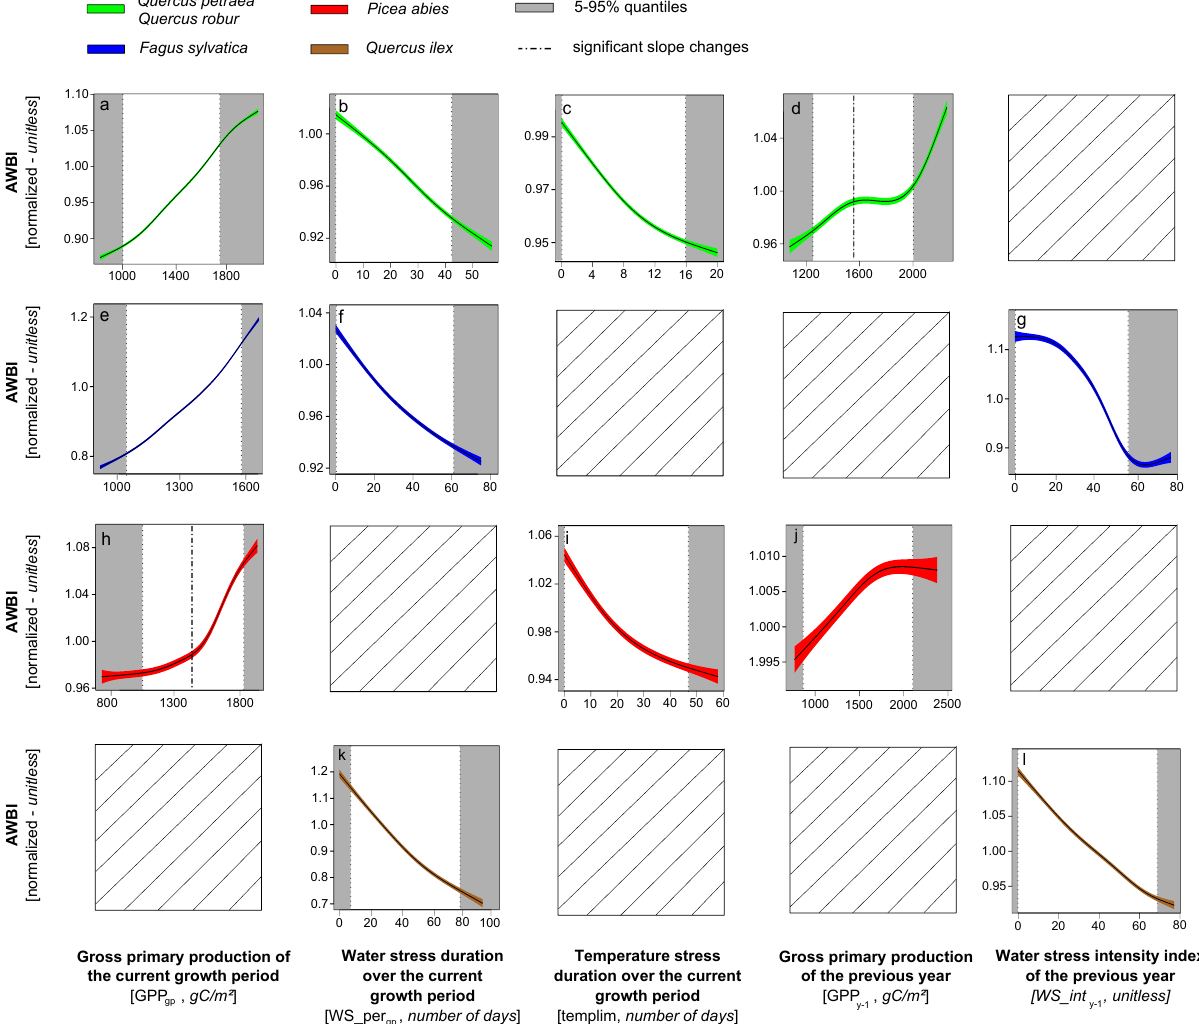
Figure 5. Temporal dependences of annual wood growth: marginal effects of each explanatory variable on the annual wood growth. The lines represent smoothing splines with 50% frequency response cut-offs. The coloured areas indicate the 95% confidence intervals. The 5 and 95% data quantiles (grey areas) were not considered in the discussion. The marginal effect of a given variable X was obtained by fixing the value of X and averaging the RF predictions over all the combinations of observed values for the other predictors in the data set (Cutler et al., 2007). The marginal predictions were collected over the entire range of X in the training data using a regular